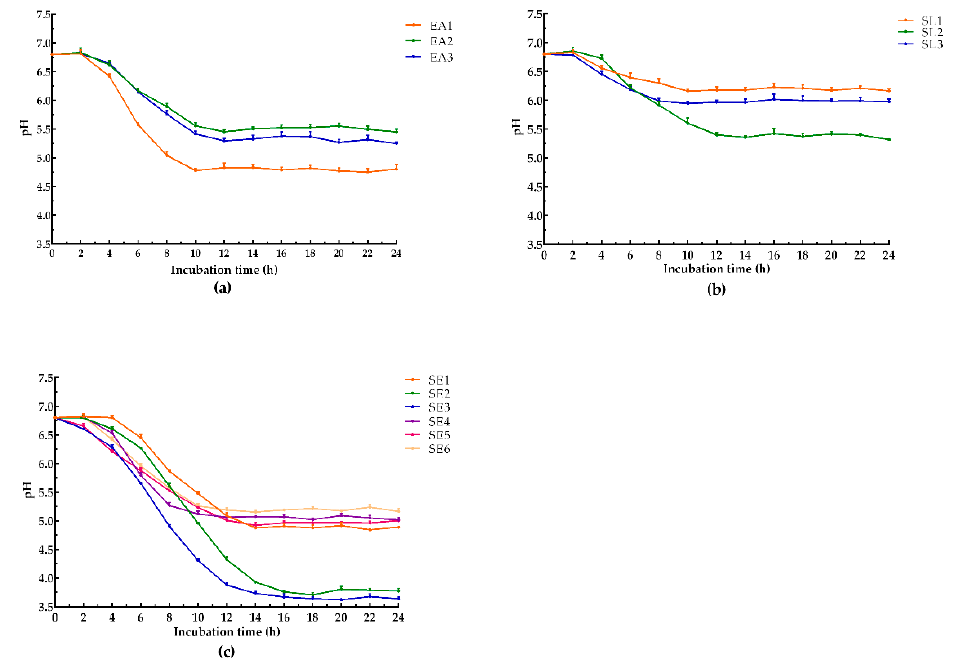
Figure 4. pH curves (means SD, n = 3) of three strains of ( a ) Enterococcus avium (EA1-3); ( b ) three strains of Streptococcus lutetiensis (SL1-3); and ( c ) six strains of Streptococcus equinus (SE1-6).